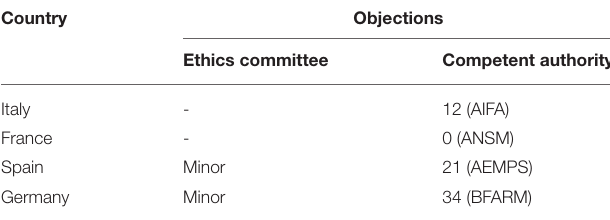
TABLE 2 | Objections by EC and